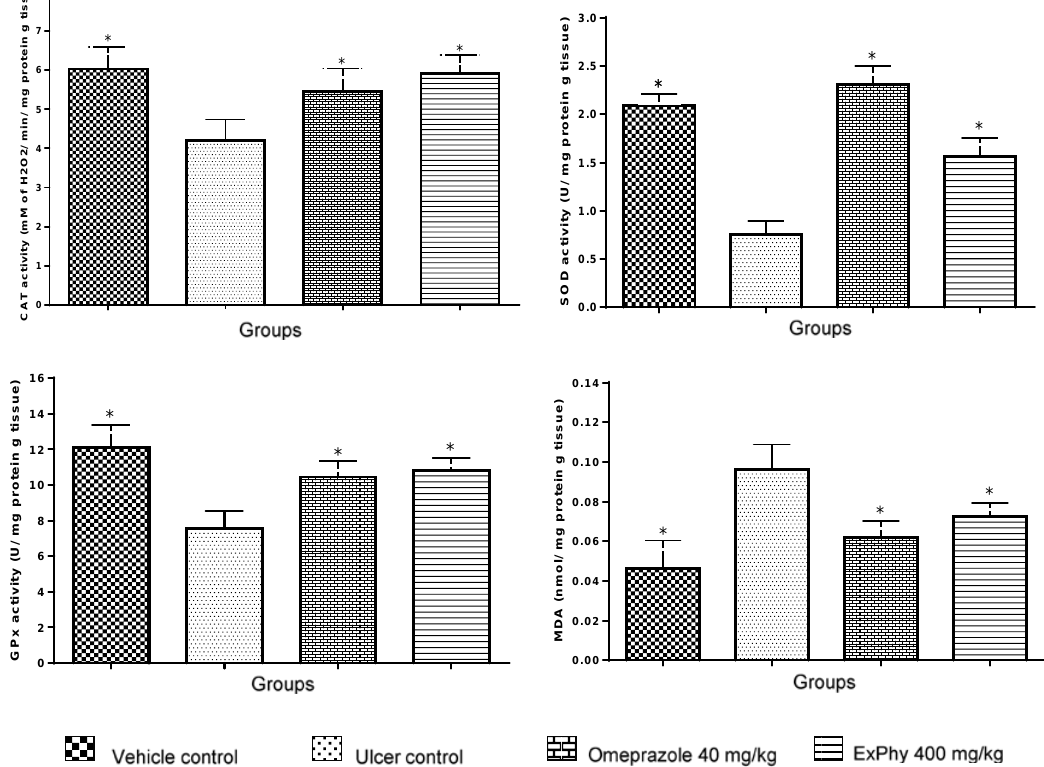
Figure 3. ExPhy and omeprazole pretreatments, followed by ethanol-induced gastric ulcers, produced protective effects on the gastric mucosal activity of GPx, SOD and CAT, as well as lowering the levels of MDA compared to the ulcer control. * Indicates p < 0.05. Data are expressed as the mean ± SEM. ExPhy, extract rich in phycobiliproteins.